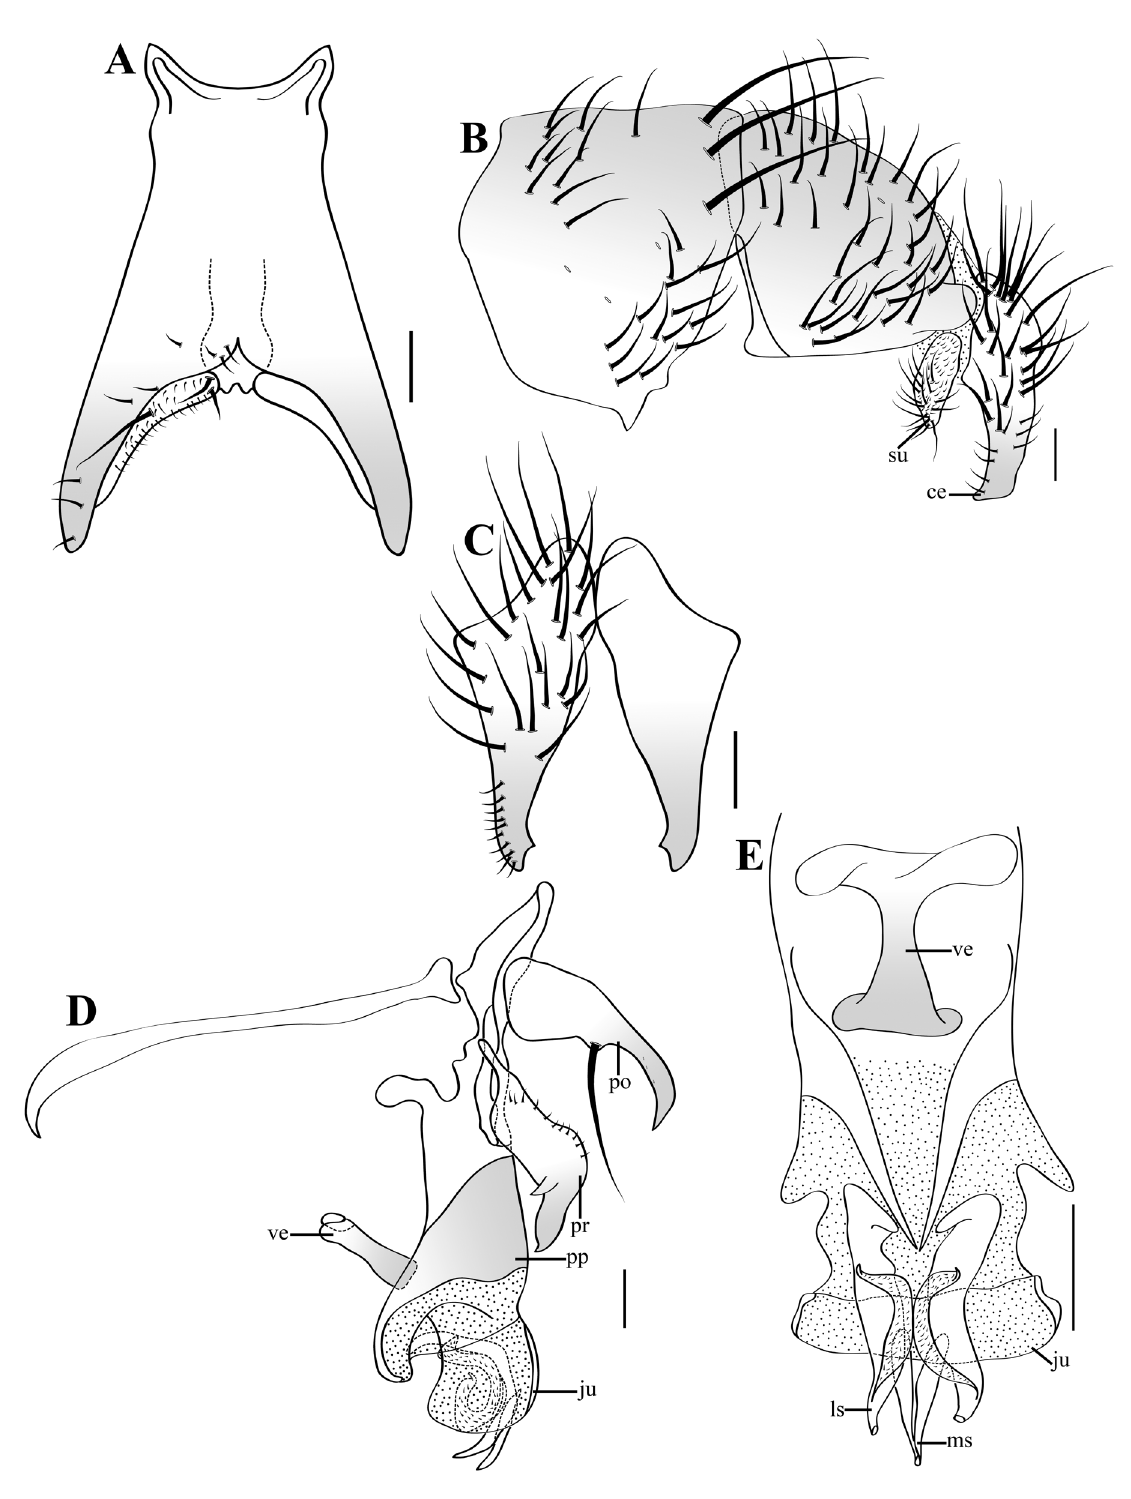
Fig. 11. Dexosarcophaga napo sp. nov., ♂, holotype (NHRS [lost]). A . Sternite 5, ventral view. B . Syntergosternite 7 + 8, epandrium, cercus and surstylus, lateral view. C . Cerci, posterior view. D . Phallus and associated structures, lateral view. E . Distiphallus, ventral view. Abbreviations: see Material and methods. Scale bars = 0.1